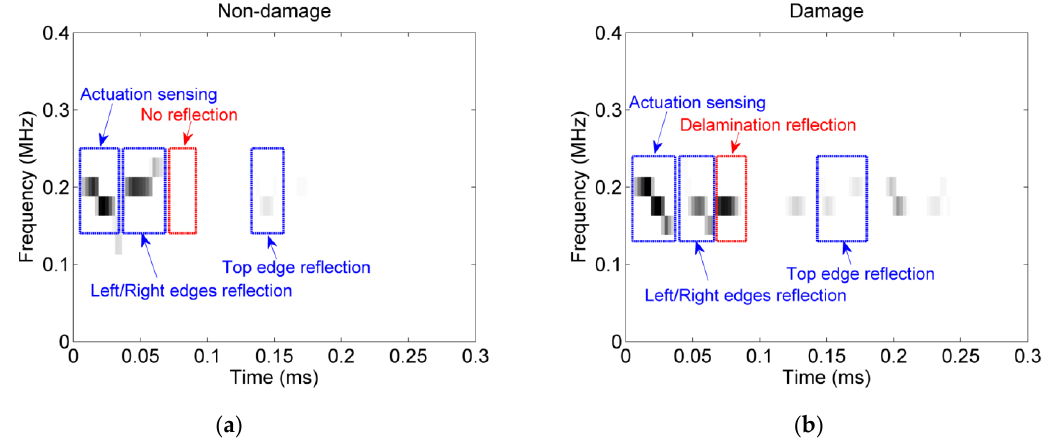
Figure 8. Energy density spectra for damage identification. ( a ) Non-damage condition; ( b ) A damaged condition—delamination presence.